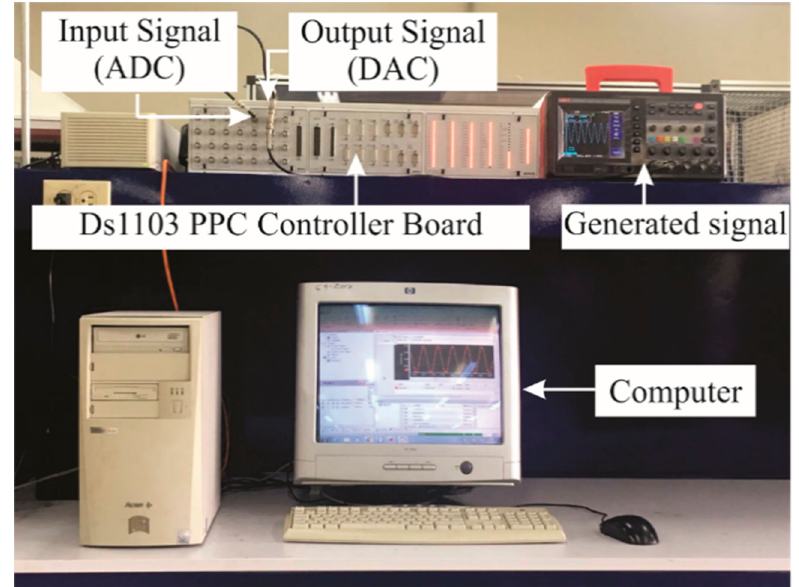
Figure 8. Experimental setup using the real time digital simulator (RTD).